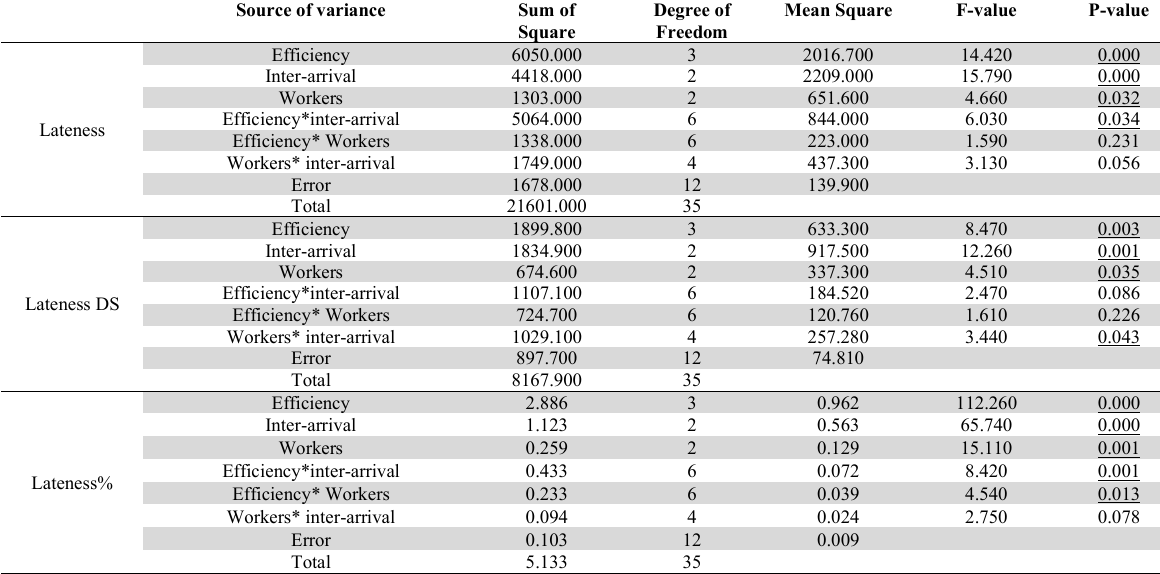
ANOVA Results - Delivery Performance